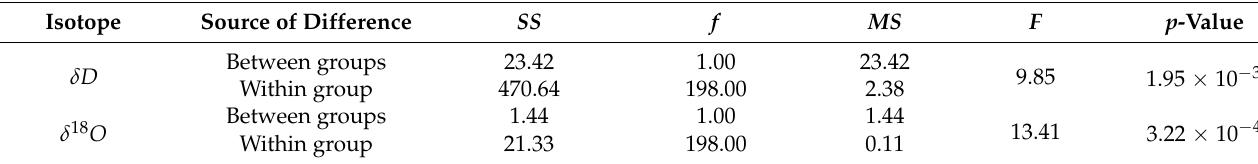
Figure 4. Comparison of ( a ) δ D and ( b ) δ 18 O values of the micro-droplet groups with different deposition conditions. Table 1. Significant test results.